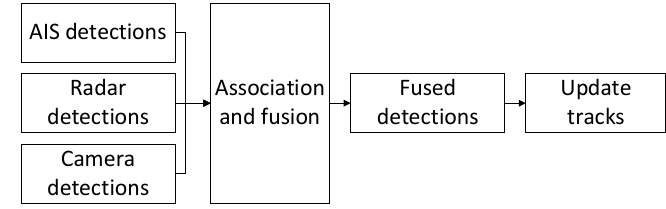
Fig. 1. Structure of Central-level fusion.